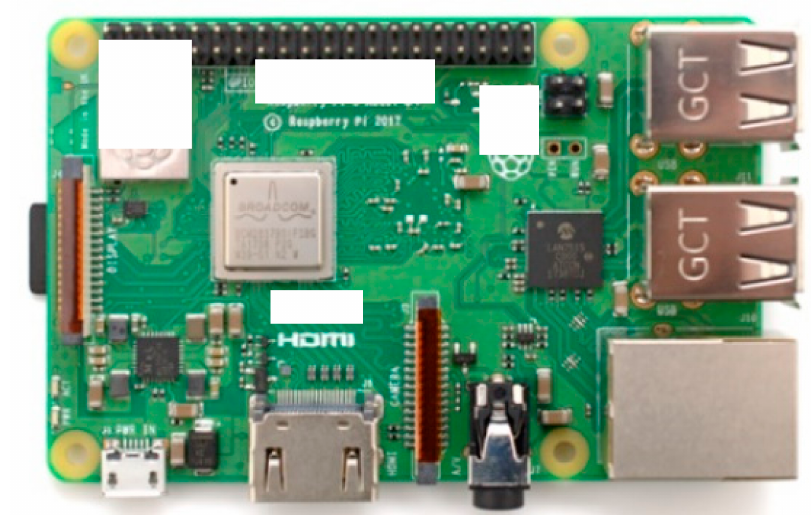
Figure 1. Single Board